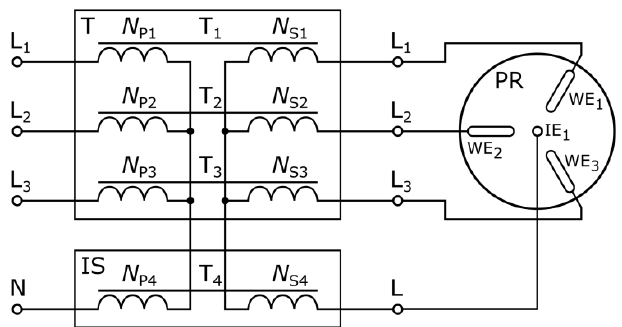
Figure 4. Integrated power system ITPS, PR — plasma reactor, T — reactor working electrode power circuit, IS — ignition electrode power circuit, N P1 , N P2 , N P3 , N P4 — primary windings, N S1 , N S2 , N S3 , N S4 — secondary windings, WE 1 , WE 2 , WE 3 — plasma reactor working electrodes, IE 1 — reactor ignition electrode.